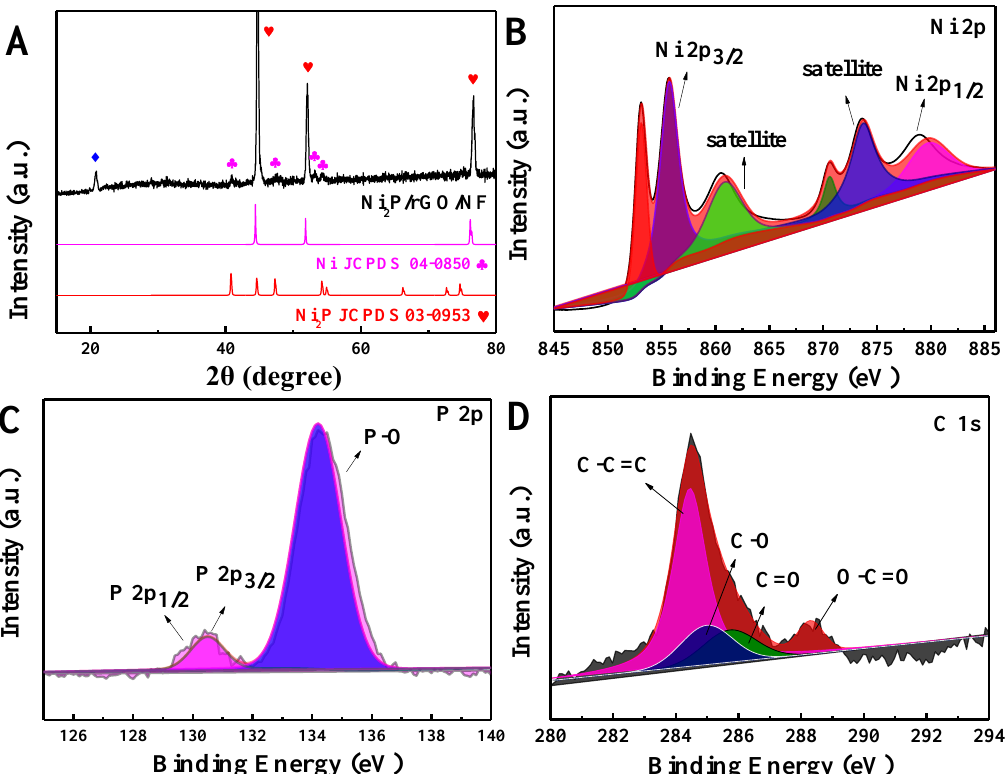
Figure 2. ( A ) X-ray Diffraction (XRD) of Ni 2 P/rGO/NF. X-ray Photoelectron Spectroscopy (XPS) of Ni 2p ( B ), P 2p 1s ( C ) and C 1s ( D ) for Ni 2 P/rGO/NF. 2p ( B ), P 2p 1s ( C ) and C 1s ( D ) for Ni